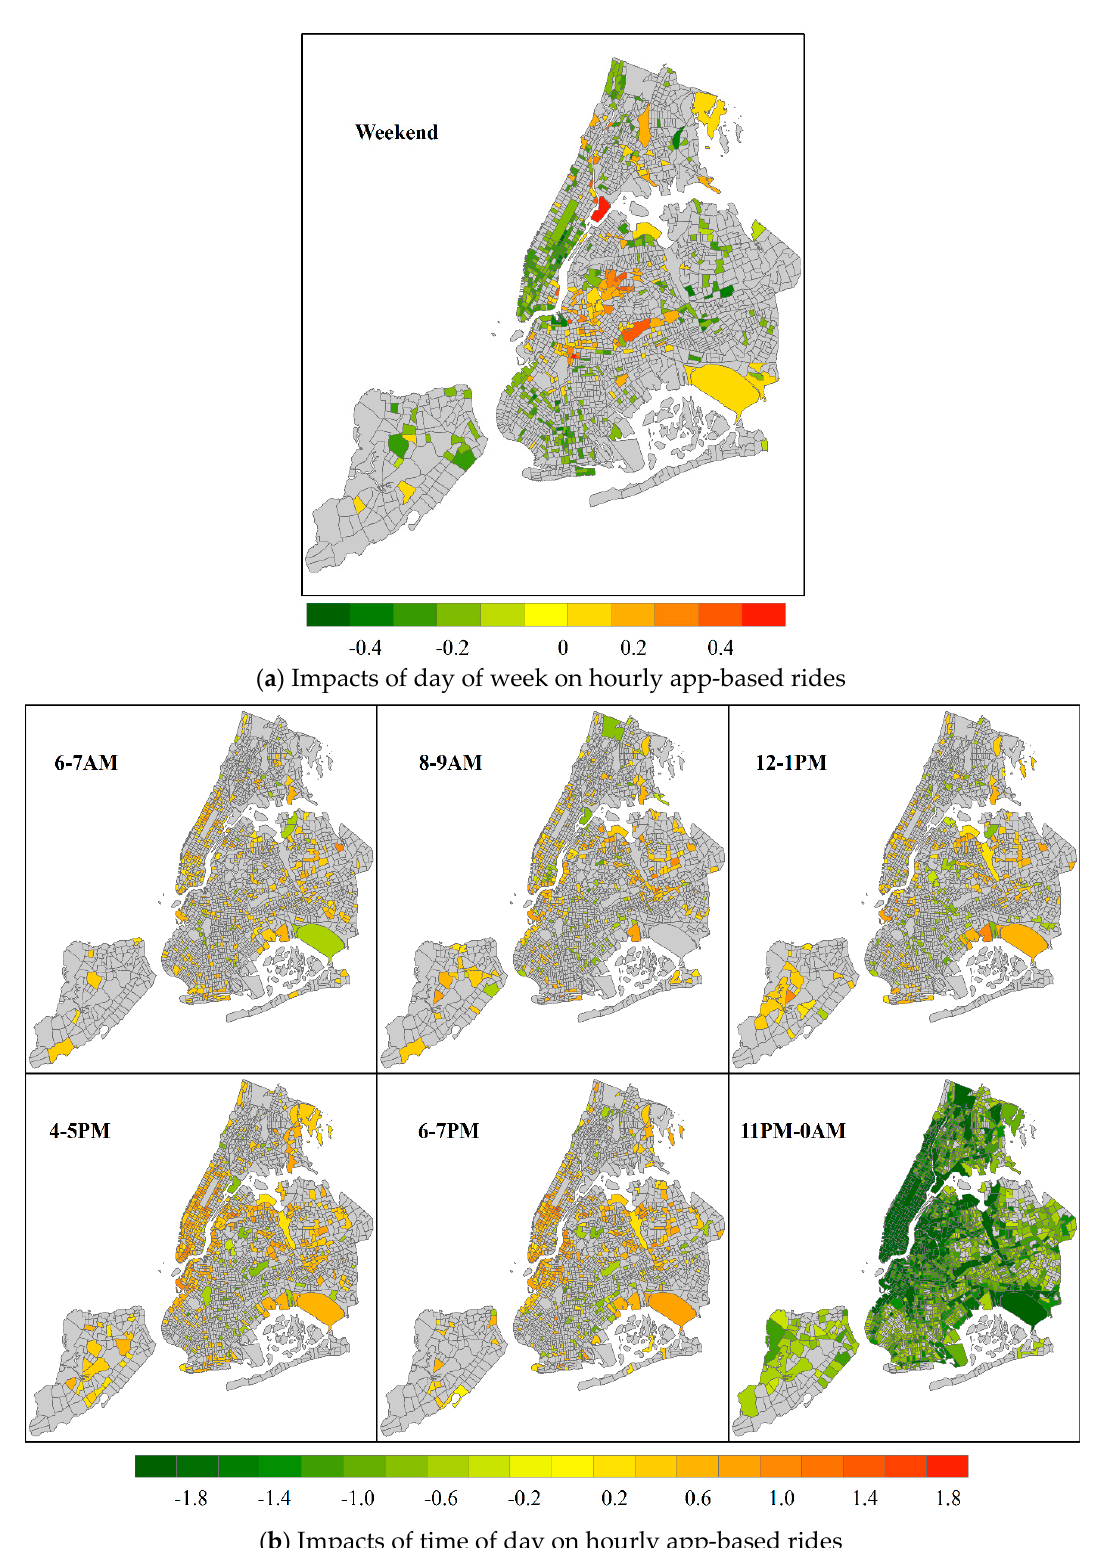
Figure 6. Impacts of temporal characteristics on hourly app-based taxi ridership. (Note grey regions mean the corresponding impacts are statistically insignificant.).